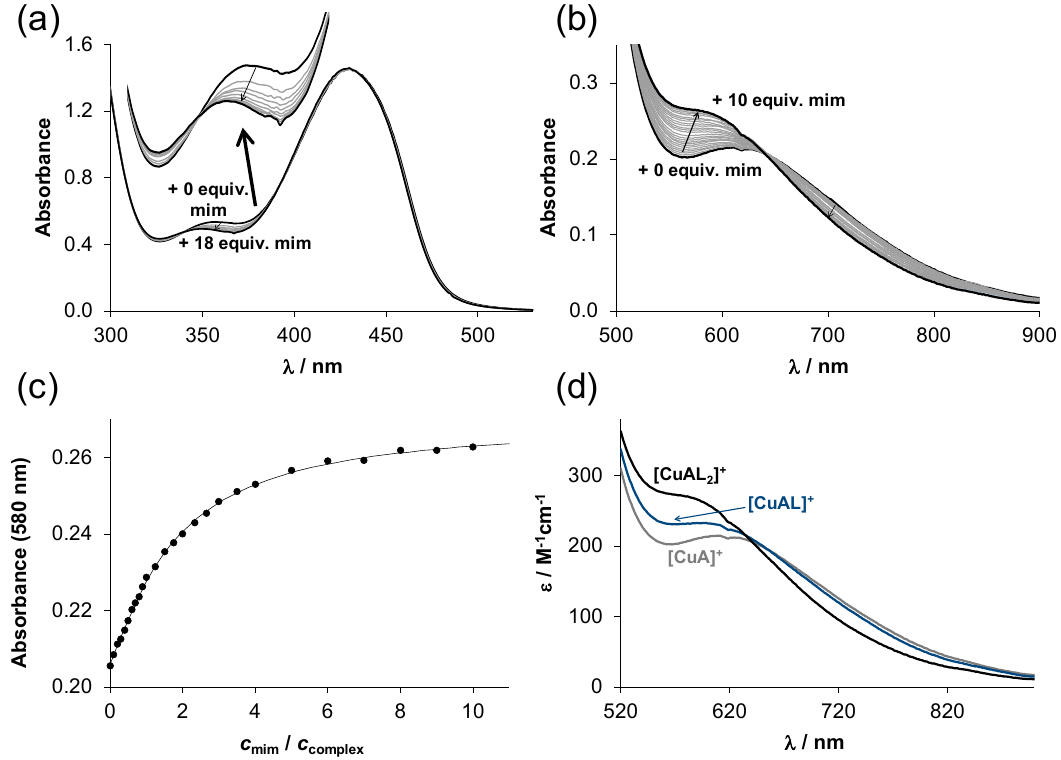
Figure 4. UV–vis spectra recorded for the copper(II) ‒ Triapine ‒ N-methylimidazole (mim) system at pH 7.4 after 5 min equilibration time in the wavelength range of the ( a ) CT bands and the ( b ) d-d bands at various equivalents of mim. ( c ) Absorbance values at 580 nm plotted against the ratio of mim and the copper(II)-Triapine complex obtained from the d-d range of the UV–vis spectra. ( d ) Calculated molar absorbance spectra of the Triapine complex ([CuA] + ), the Triapine-mim ternary complexes ([CuAL] + and [CuAL 2 ] + ). {30% ( w / w ) DMSO/H 2 O; pH = 7.4 (20 mM HEPES); T = 25 °C; I = 0.10 M (KCl); a: c Cu(II) = c Triapine = 102 µ M, c mim = 0–1.80 mM; (cid:96) = 1 cm; b: c Cu(II) = c Triapine = 250 µ M, c mim = 0–2.50 mM; (cid:96) = 4 Table 3. Conditional stability constants (log K ’) for the formation of ternary copper(II) ‒ STSC ‒ DAHK/mim/HSA com- plexes in 30% ( w / w ) DMSO/H 2 O at pH 7.4 (20 mM HEPES) determined by UV–vis spectrophotometric measurements. In systems of DAHK and HSA 4 h, while with min only 5 min equilibration time was applied. Uncertainties (SD) of the last digits are in parenthesis. { T = 25 °C; I = 0.10 M (KCl)}. Triapine STSC